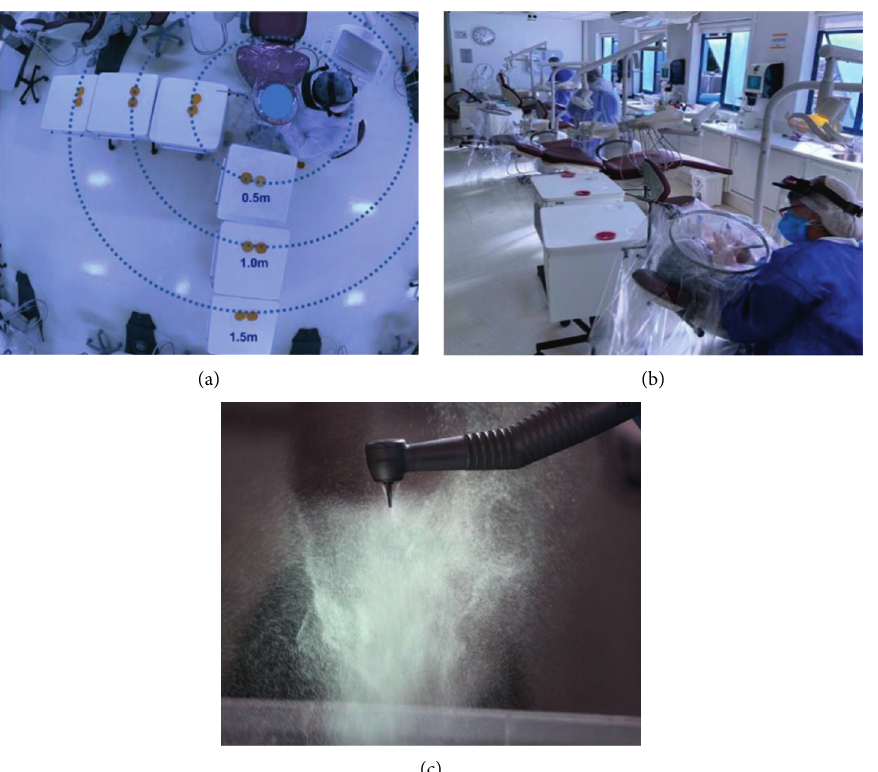
Figure 2: Petri dish distribution in relation to the head of the dental chair (a), Petri dishes at the orthodontic dental clinic during patient consultation with the IBCD (b) and high-speed dental handpiece in operation mode showing aerosol production (c).